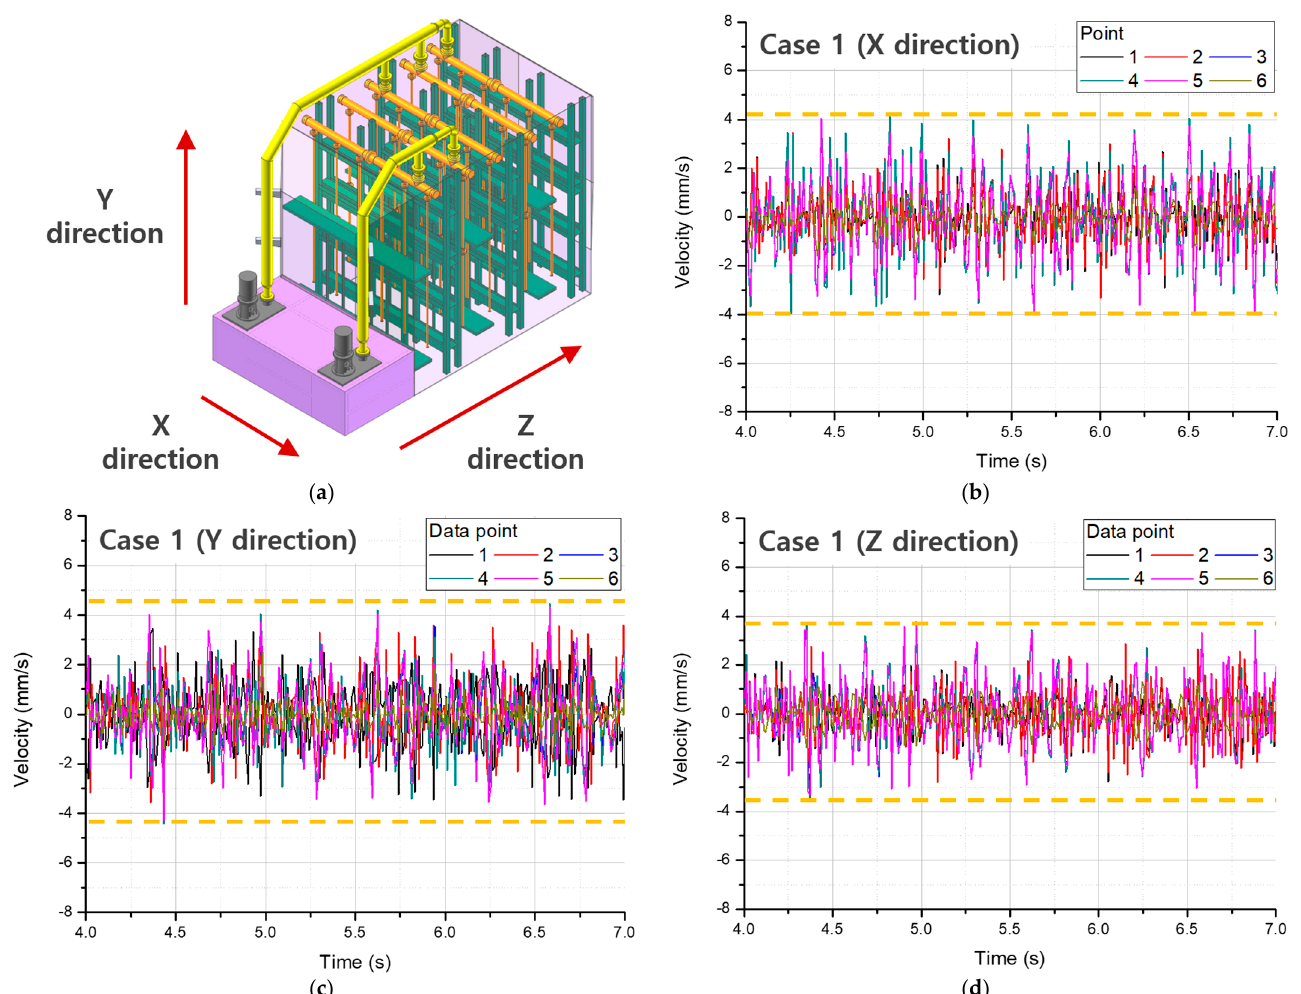
Figure 11. Case 1—vibration velocity according to the axial direction: ( a ) Axial direction display; ( b ) X direction; ( c ) Y direction; ( d ) Z direction.